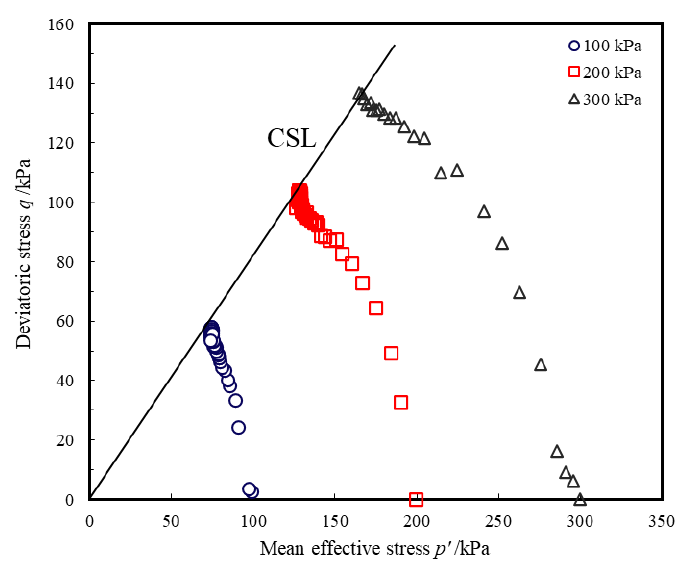
Figure 8. Effective stress paths in CU test.